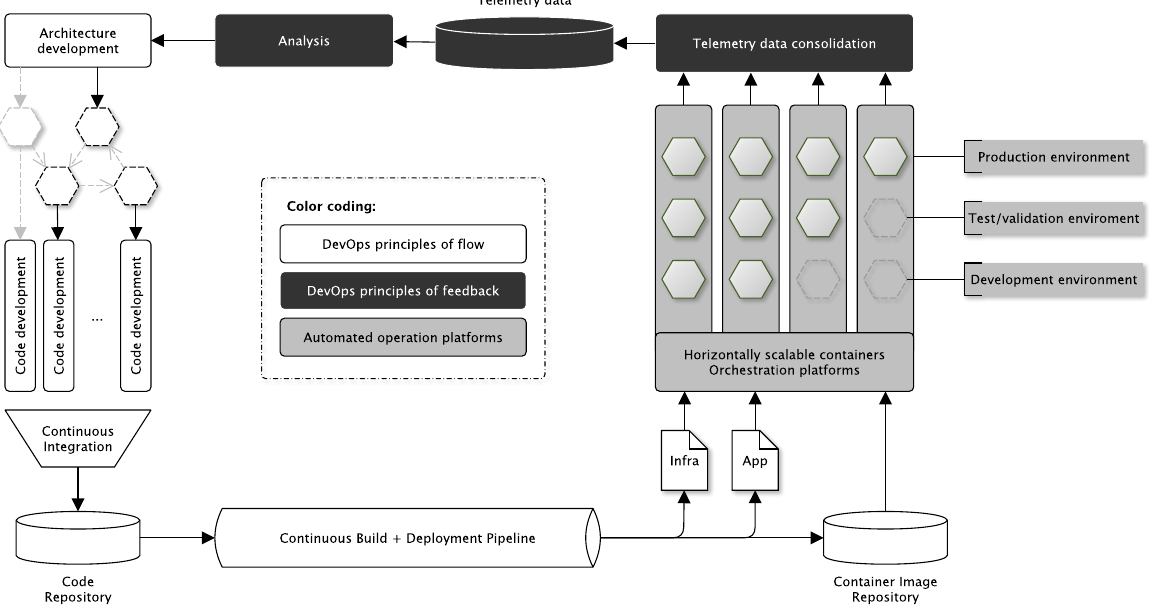
Figure 1. Observability can be seen as a feedback channel from Ops to Dev (adopted from